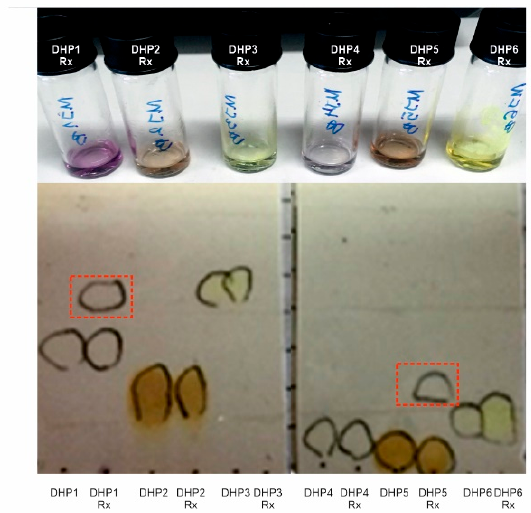
Figure 3. Biocatalytic reactions of DHP1-DHP6 using Tv Lacc as biocatalyst. Reactions after 18 h incubation and extraction with ethyl acetate are depicted in the upper panel and thin-layer chromatography analysis of DHP substrates and corresponding biotransformation products (eluent hexane/ethyl-acetate= 1/1, UV visualization). Red rectangles indicate DHP1 and DH5 reaction products. Reaction mixtures were analysed by HPLC, as well (Figures S8–S13). We found that